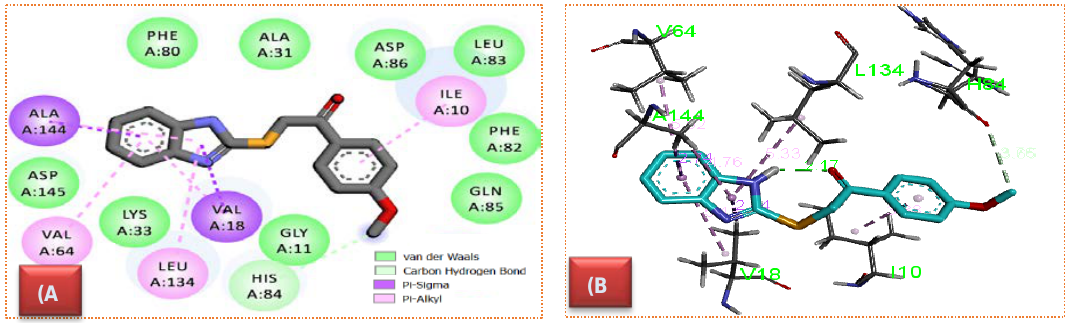
Figure 5. (A) 2D and (B) 3D diagram of benzimidazole 10d displaying its interaction within CDK2 kinase active site (distances in Å).